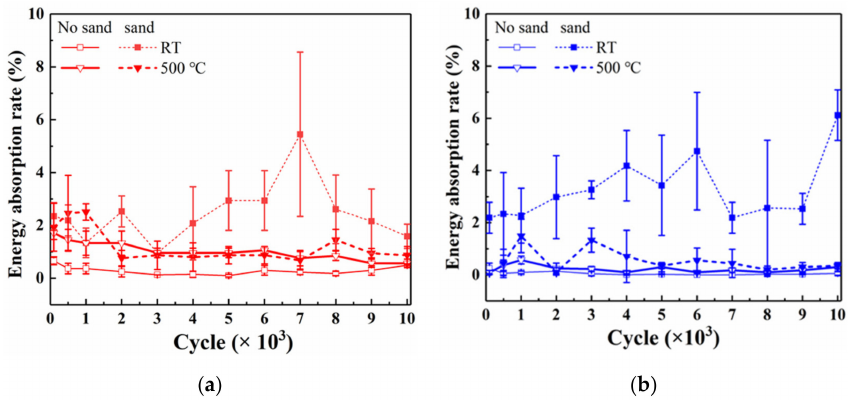
Figure 6. Energy absorption rate at different cycles in the throughout the cycle. ( a ) CrN coating, and ( b ) CrAlN